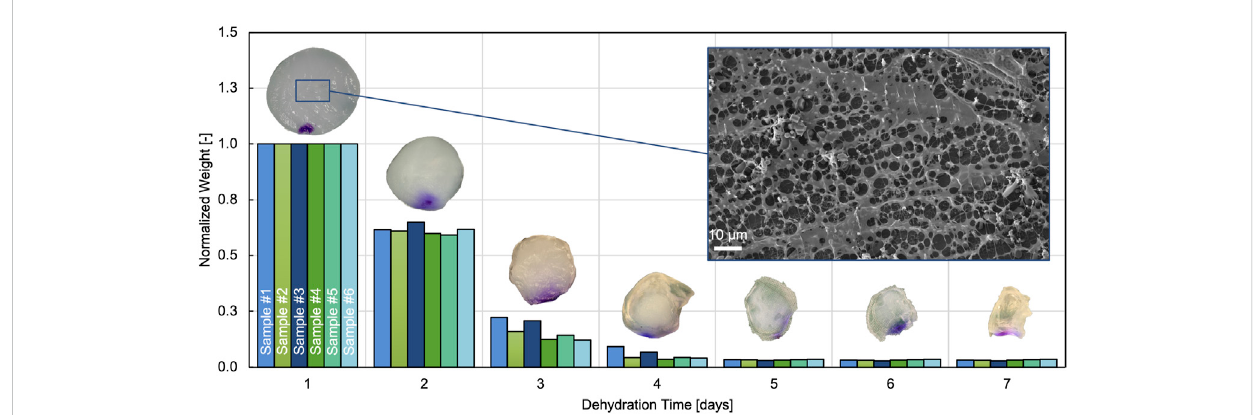
FIGURE 5 Evolution of normalized weight over dehydration time for 6 different samples. Only the fi rst 7 days are shown because no weight changes could be measuredafterthat.Theinsetontopofeachbargroupillustratesrepresentativehydrogelsamplesontherespectivedayofdehydration.Alsoincludedisa representative SEM image of the hydrogel microstructure.